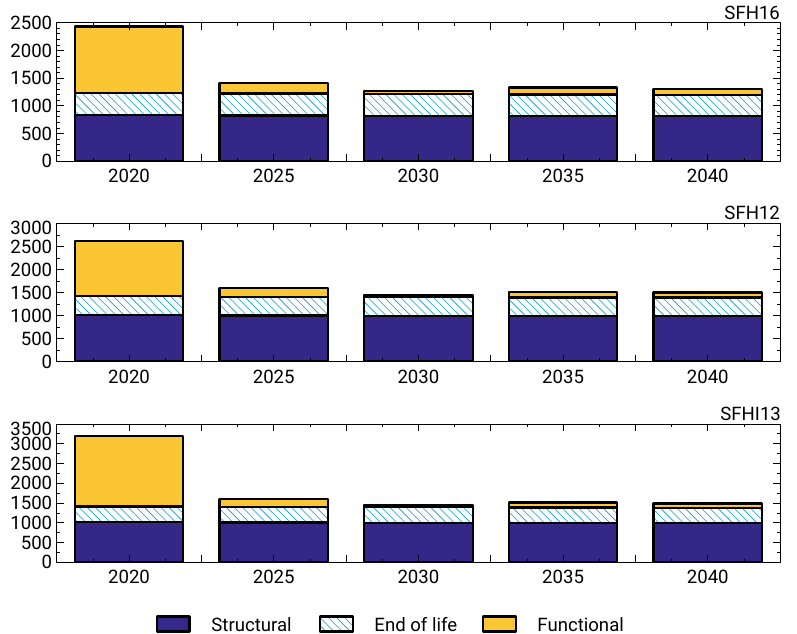
Figure 9. Effect of electricity decarbonization on the three typical SFHs through the GWP in kg CO 2 eq/m 2